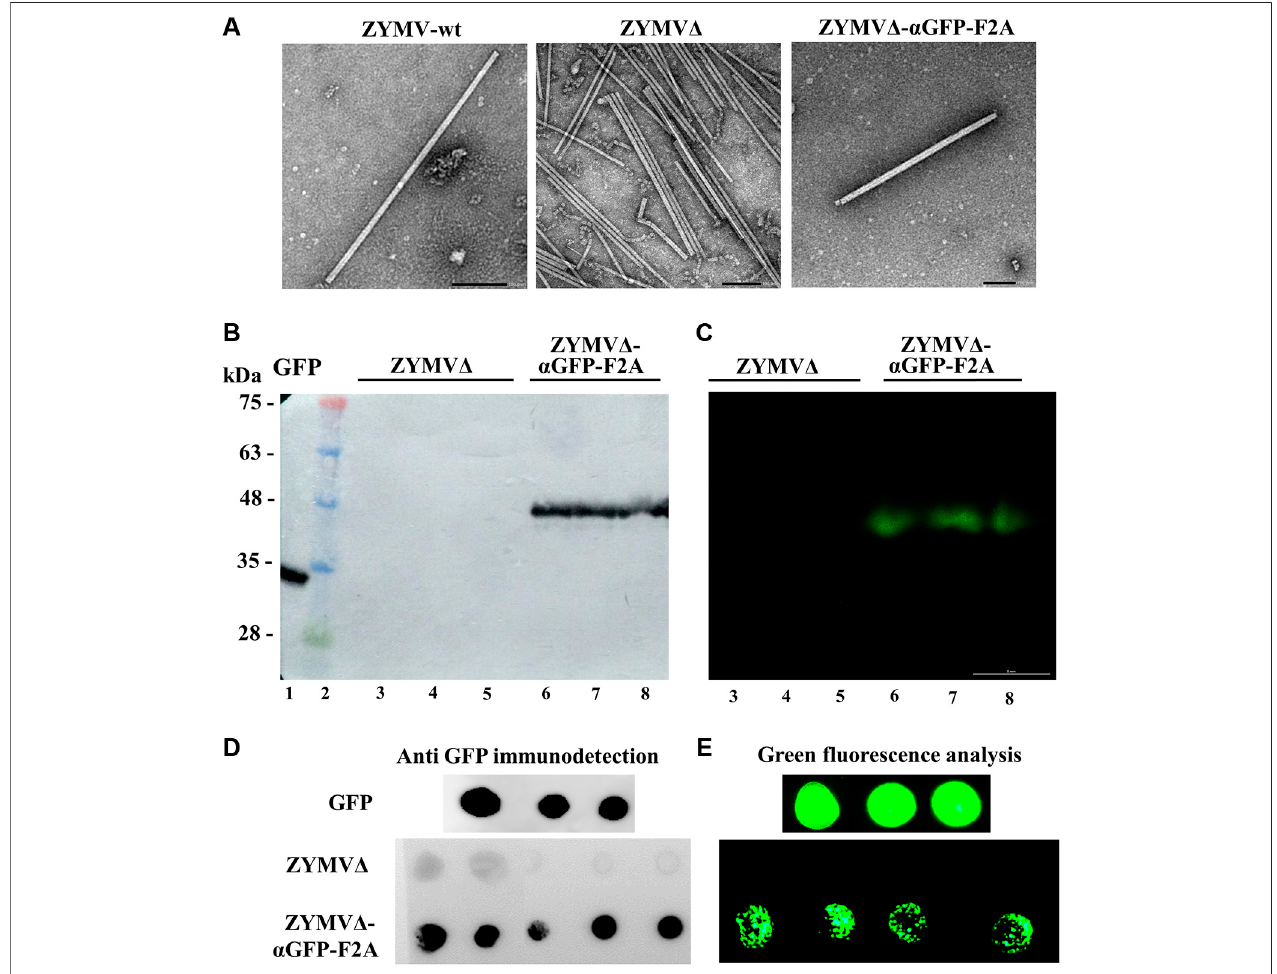
FIGURE4| Antigen-bindingcapacityofZYMVVNPs. (A) TEMmicrographsofpuri fi edZYMV-wt,ZYMV Δ ,andZYMV Δ - α GFP-F2Avirions,asindicated.Scalebaris 100 nm. (B , C) GFP-binding properties of ZYMV α GFP-F2A-CP Δ capsomers. Virion preparations from zucchini plants infected with ZYMV Δ and ZYMV Δ - α GFP-F2A wereseparatedbySDS-PAGEintriplicate,andtheproteinsweretransferred toamembrane.ThemembraneswereincubatedwithrecombinantGFPandwashed;GFP was revealed by (B) reaction with a speci fi c antibody or (C) by directly imaging the green fl uorescence. Lane 1, recombinant GFP; lane 2, protein standards with sizes in kDa on the left; lanes 3 to 8, virion preparations from plants infected with ZYMV Δ (lanes 3 – 5) or ZYMV Δ - α GFP-F2A (lanes 6 – 8). (D , E) Dot-blot analysis of the GFP-binding activity of ZYMV Δ - α GFP-F2A virions. Aliquots of virion preparations from plants infected with ZYMV Δ and ZYMV Δ - α GFP-F2A, as indicated, were spotted on membranes that were incubated with recombinant GFP, and GFP detected with a speci fi c antibody (D) or the fl uorescence directly analyzed using a stereomicroscope (E) . Membranes in which aliquots of recombinant GFP were spotted were used as a positive control.